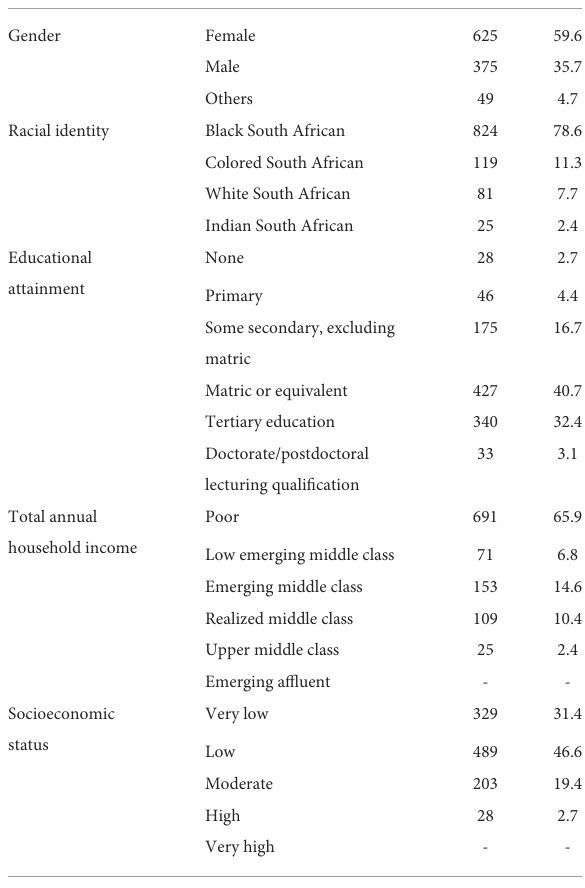
TABLE 1 Sample characteristics ( n =